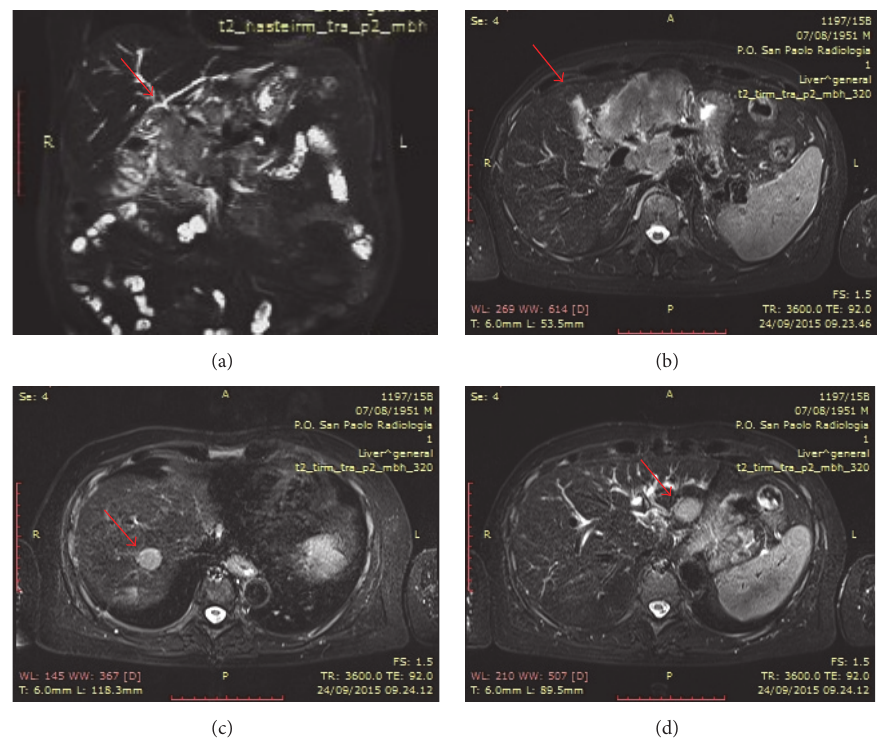
Figure 3: MR cholangiopancreatography after VBD therapy. Panels (a) and (b) show progression of extramedullary disease in the primary site (increase of dimension) and panels (c) and (d) show the appearance of new lesions in the